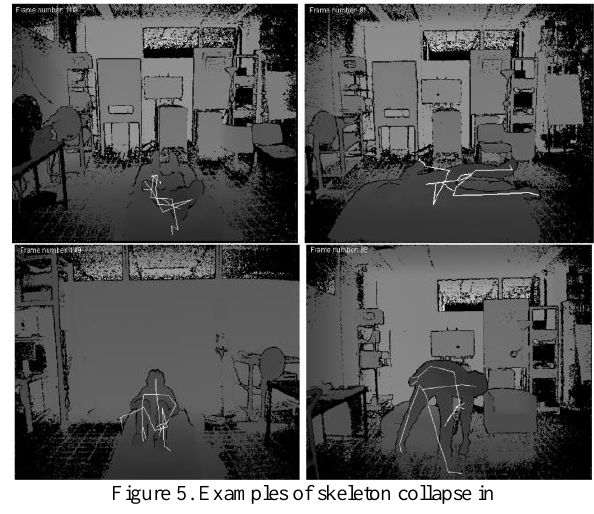
Figure 5. Examples of skeleton collapse in TST Fall Detection dataset v2